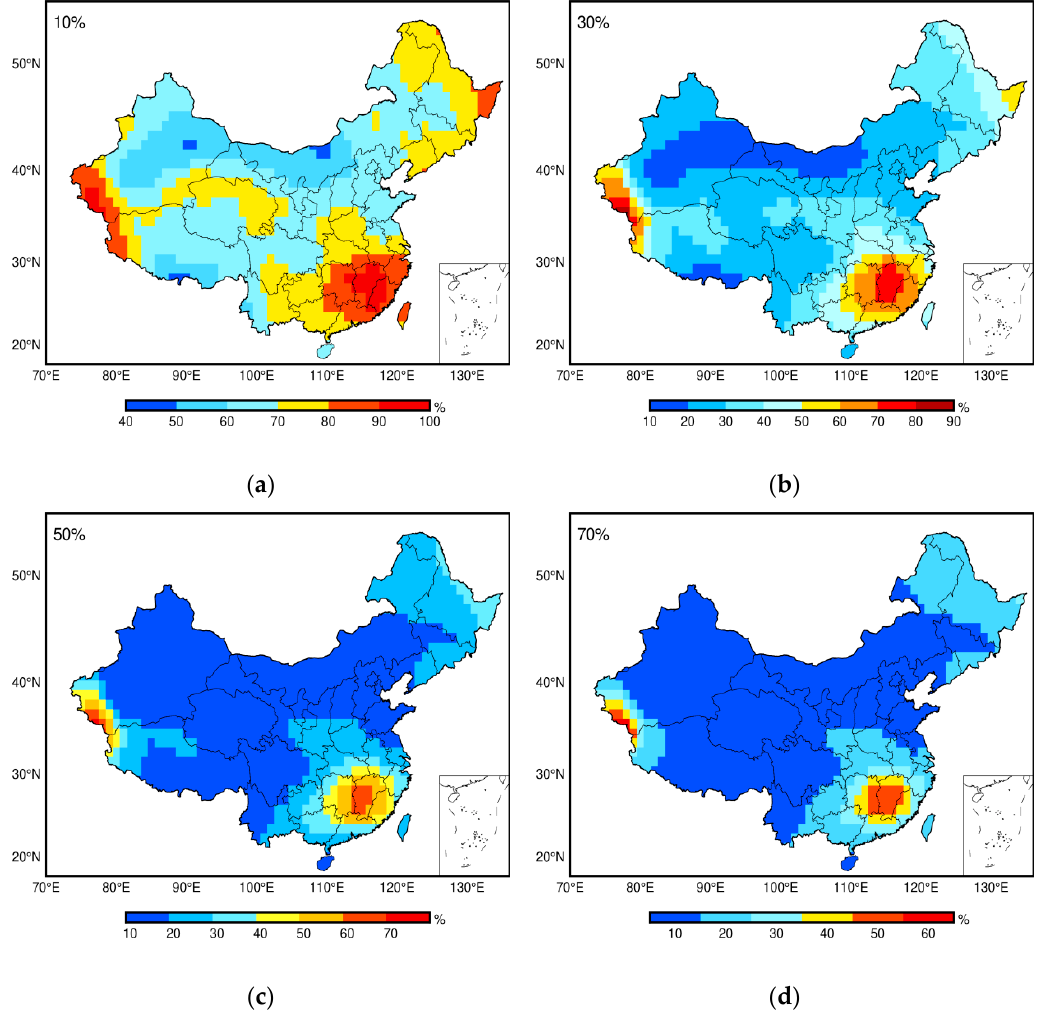
Figure 7. Percentage of epochs for annual signal bias related to LS: ( a ) larger than 10%; ( b ) larger than 30%; ( c ) larger than 50%; and ( d ) larger than 70%.